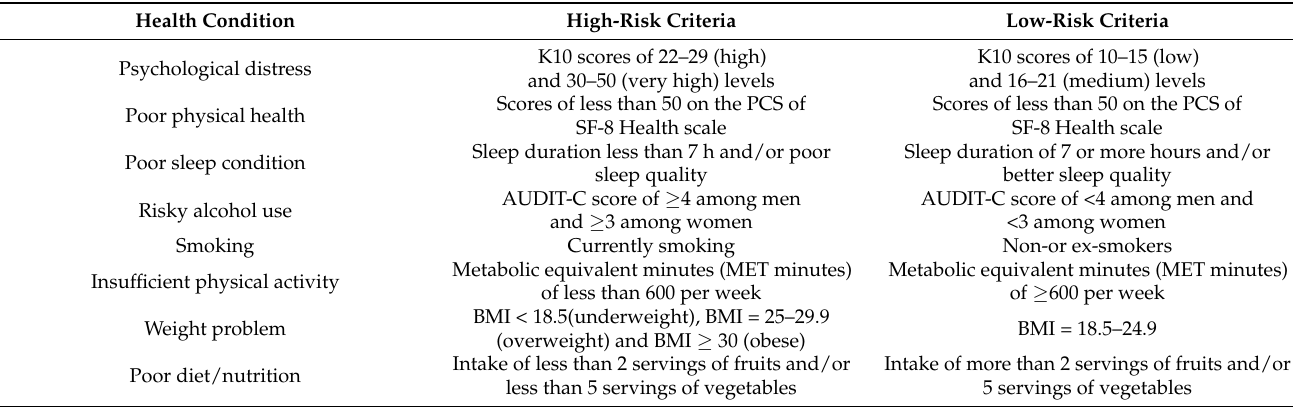
Table 1. High- and low risk classification for health